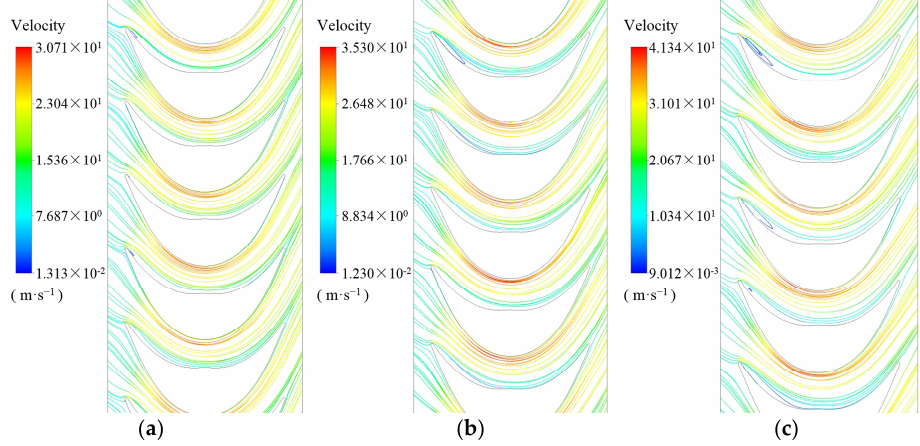
Figure 12. Streamlines for different hub to tip ratio ν and φ = 1.03. ( a ) ν = 0.6, ( b ) ν = 0.7, ( c ) ν =